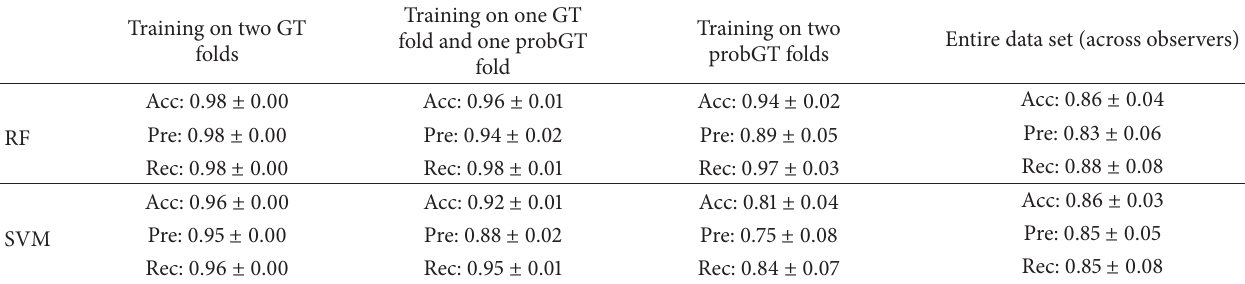
Table 2: The performance of the classifiers when trained on two folds from probGT and GT in different combinations. It is cyclically tested on one GT fold that was not used for training. Training on two GT Training on two